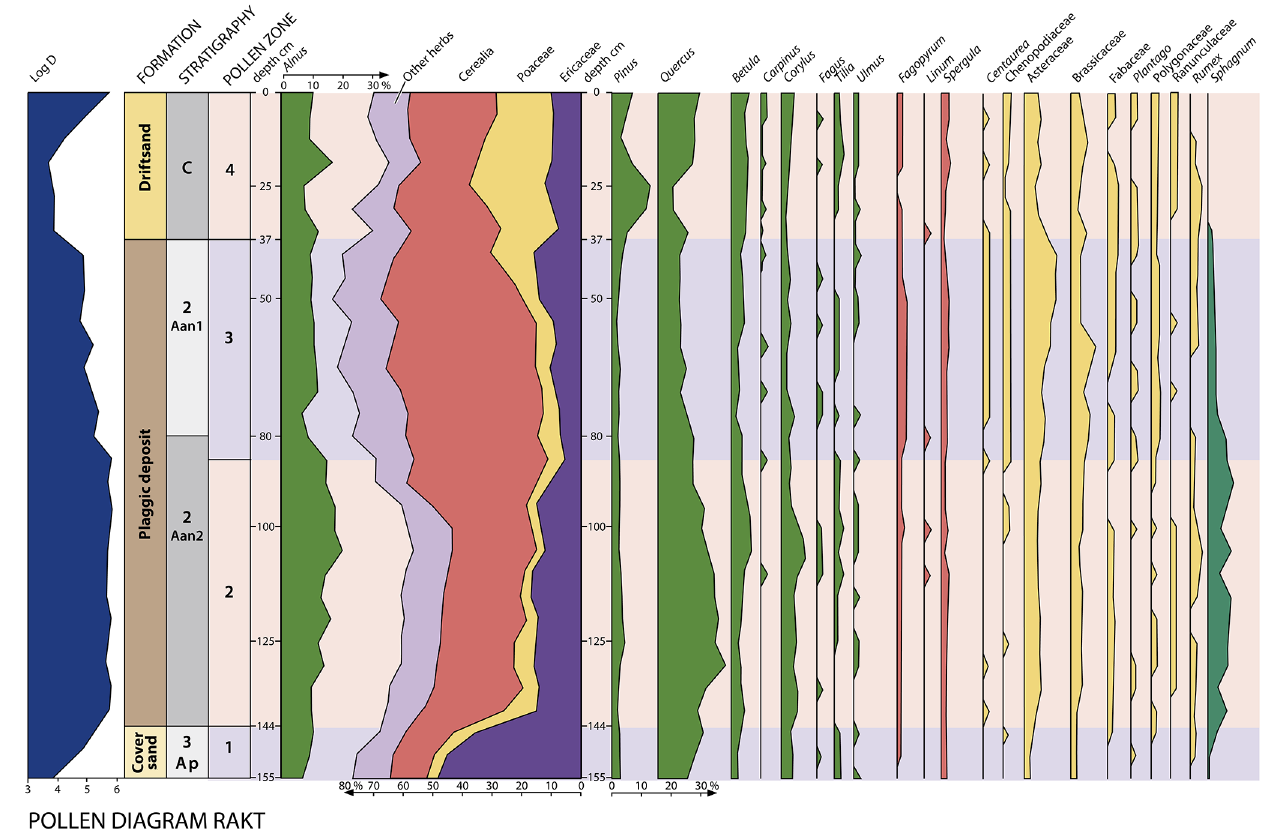
Figure 13. Pollen diagram of